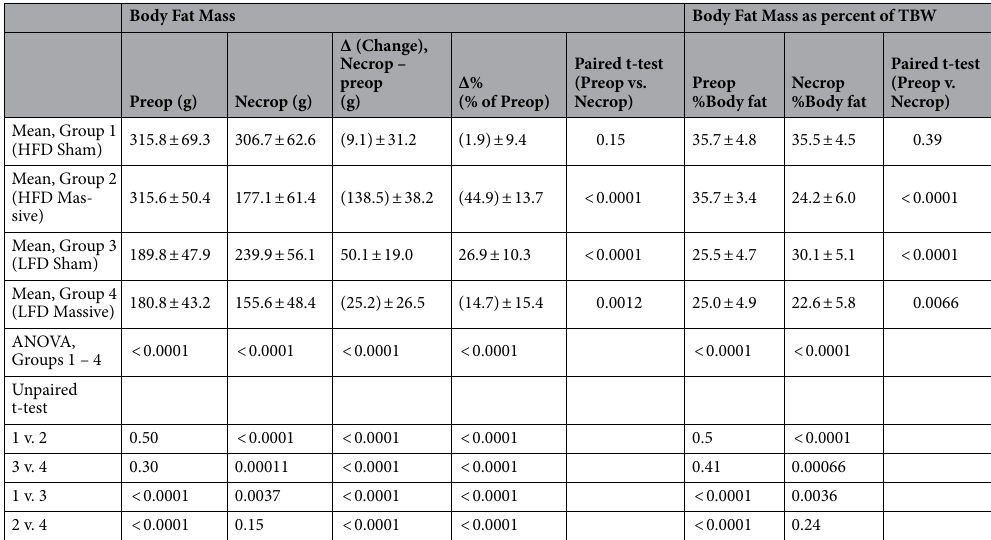
Table 6. Effect of diet and resection on body fat. Values shown are mean ± standard deviation. Red values in parentheses (xx.x) represent a negative change (decrease). Preop = Preoperative (after dietary induction, immediately prior to resection); Necropsy = immediately prior to necropsy (two months after resection); HFD = High-Fat Diet; LFD = Low-Fat Diet; Massive = Massive 75% distal small intestinal resection; Sham = Sham resection; TBW = Total Body Weight.